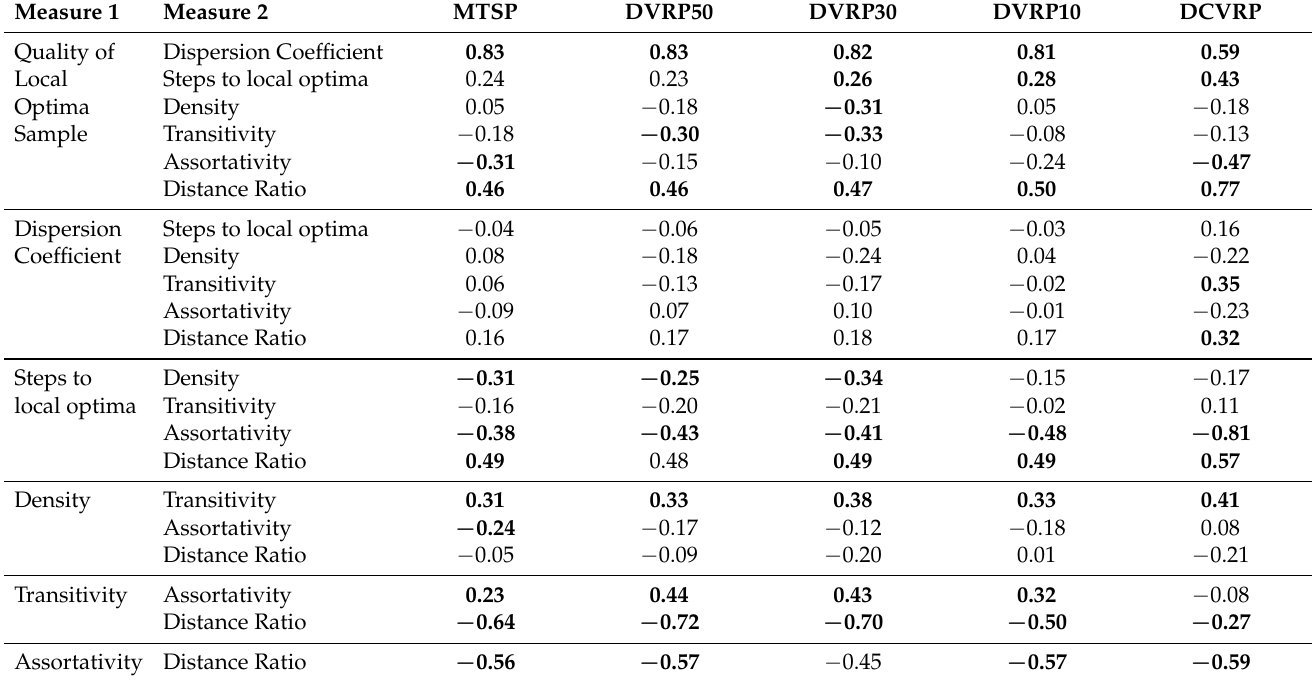
Table 5. Spearman Rank Correlation for LONA measures, comparison for the distance attribute. Bold values denotes the coefficients that are significant at a α =